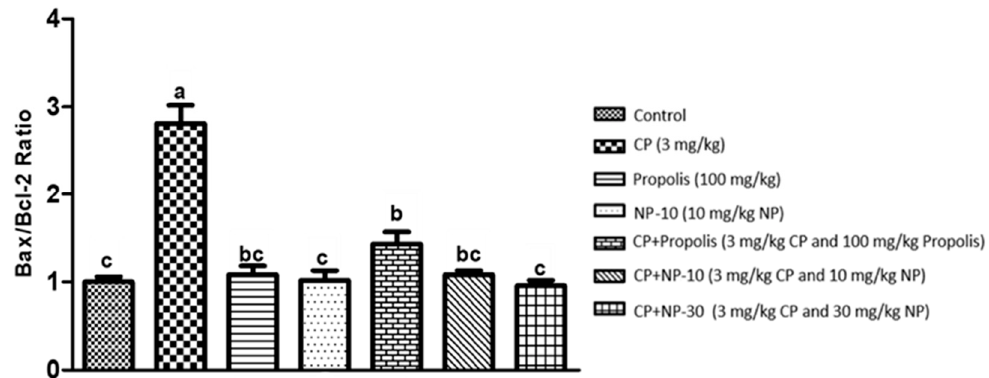
Figure 3. Bax / Bcl-2 protein expression ratio in liver tissue. a,b,c: Mean values within a row di ff er Figure 3. Bax/Bcl-2 protein expression ratio in liver tissue. a,b,c: Mean values within a row differ significantly, Significance is p < 0.001 (CP: cisplatin; NP: significantly, Significance is p < 0.001 (CP: cisplatin; NP: nano-propolis). Figure 3. Bax/Bcl-2 protein expression ratio in liver tissue. a,b,c: Mean values within a row differ Figure 3. Bax/Bcl-2 protein expression ratio in liver tissue. a,b,c: Mean values within a row differ significantly, Significance is p < 0.001 (CP: cisplatin; NP: nano-propolis). significantly, Significance is p < 0.001 (CP: cisplatin; NP: nano-propolis).